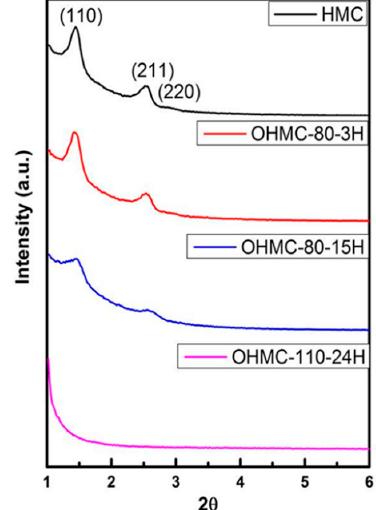
Figure 4. XRD of HMC and O-HMC with modified parameters.